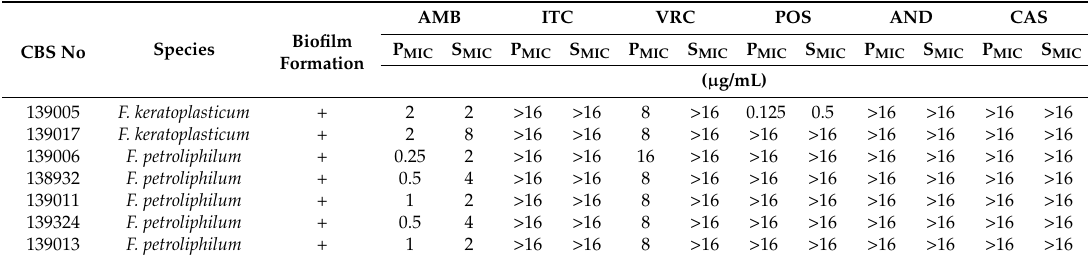
Table 2. Comparison of planktonic and sessile susceptibilities of biofilm-forming Fusarium isolates.